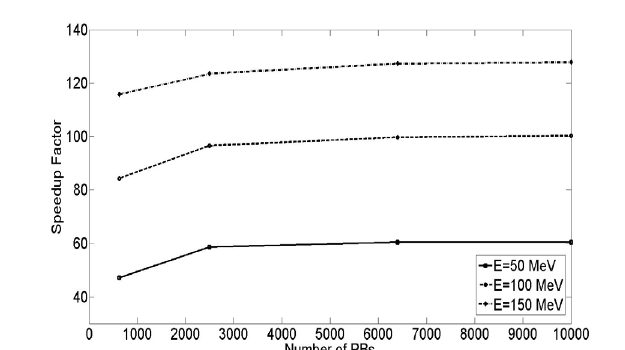
Fig. 10. Speedup factors as a function of energy and number of